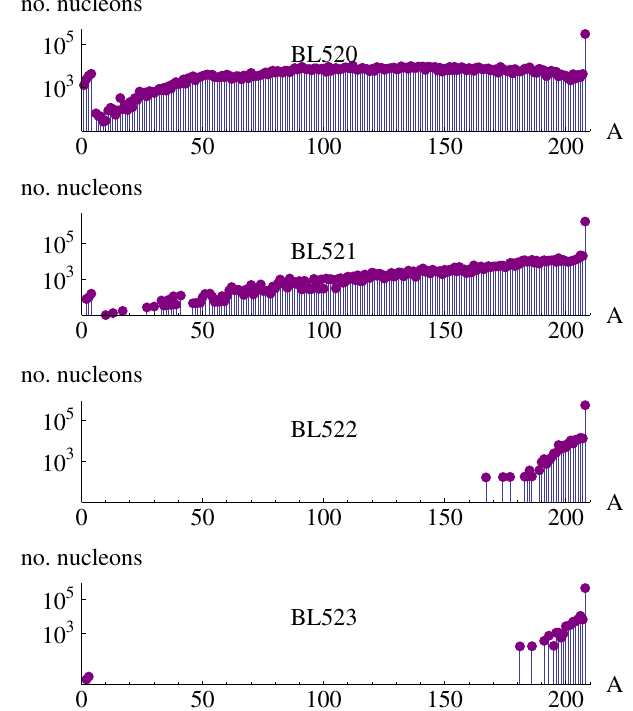
FIG. 18. (Color) The simulated A distribution of ion fragments from the FLUKA full method lost within 15 m upstream of each BLM at 5 : 9 GeV = nucleon . The heights of the bars show the number of nucleons from ions having a certain A .